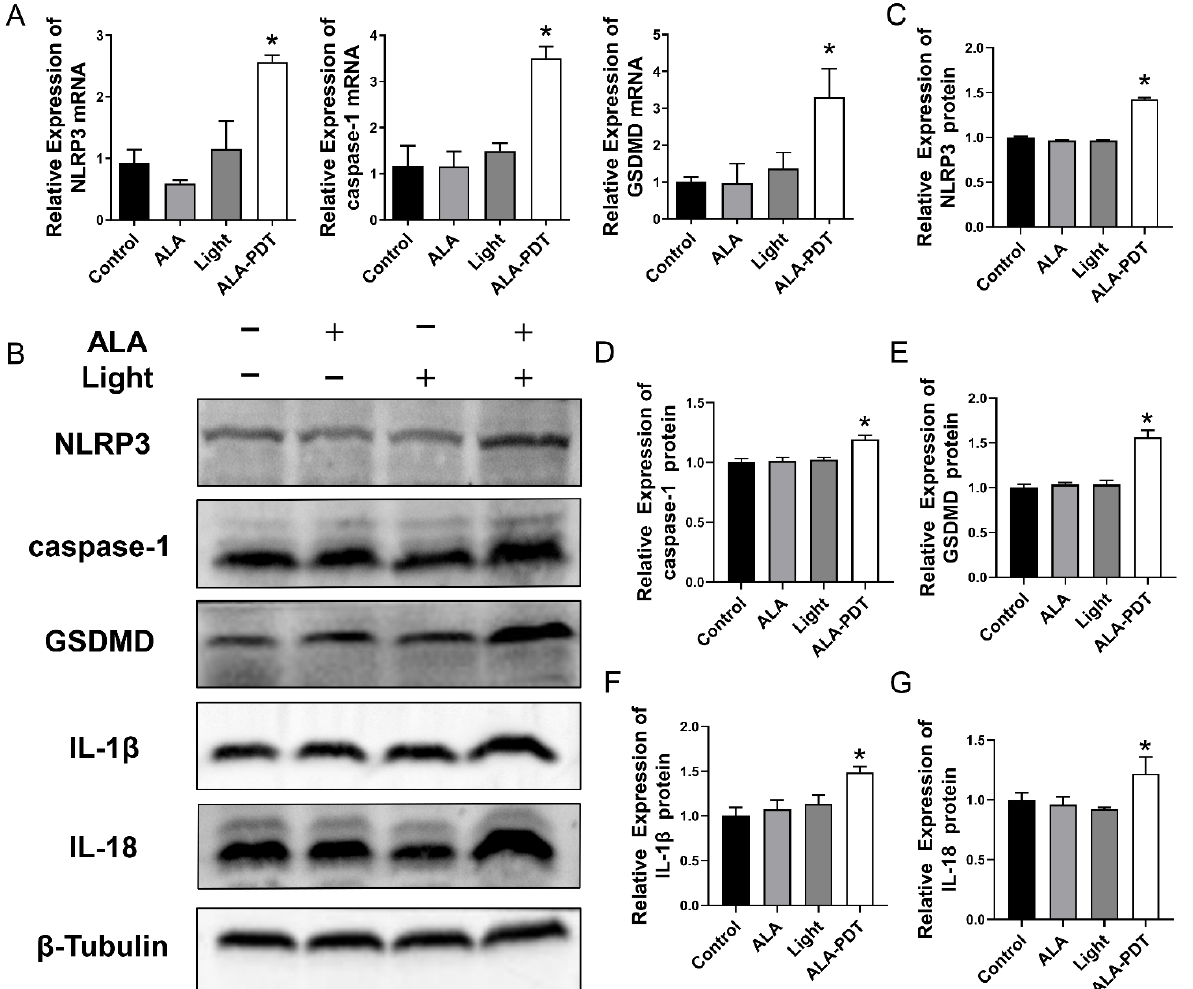
Figure 2. ALA-PDT induces pyroptosis in HeLa cells. ( A ) The mRNA expression of NLRP3, caspase- 1, and GSDMD was detected by qPCR. * p < 0.05 compared with the control group. ( B ) The protein expression of NLRP3, caspase-1, GSDMD, IL-1 β , and IL-18 was detected by western blot. ( C – G ) Statistical analysis of the protein levels of NLRP3, caspase-1, GSDMD, IL-1 β , and IL-18. * p < 0.05 compared with the control group.